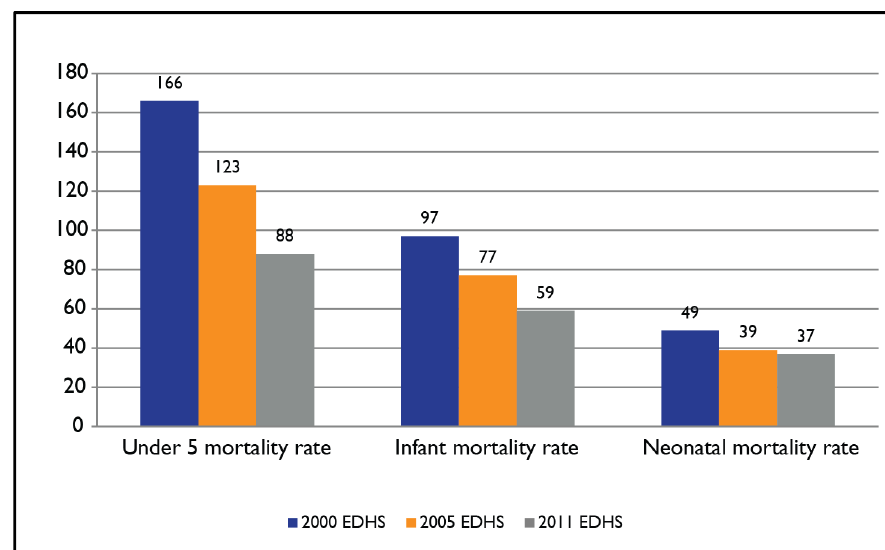
Figure 2. Trends in maternal mortality ratios (maternal deaths per 100,000 live births). Sources: [16–18].